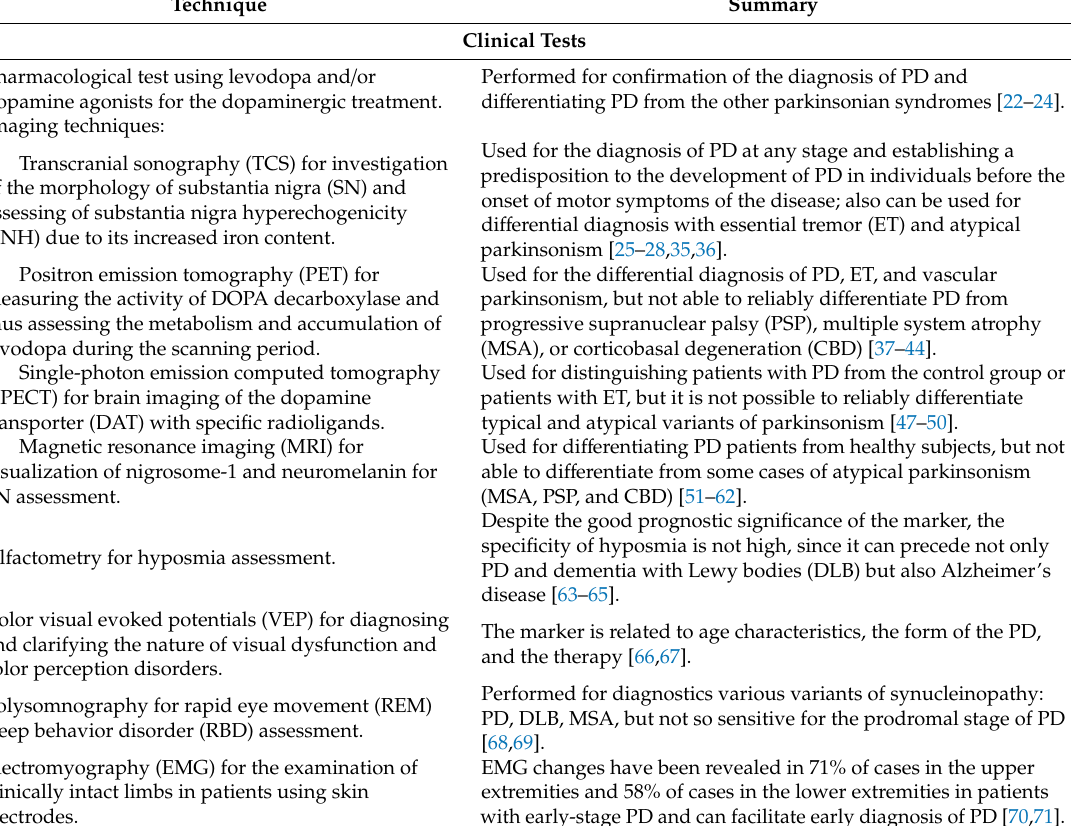
Table A1. Summary of the main clinical and promising omics-based tests for PD